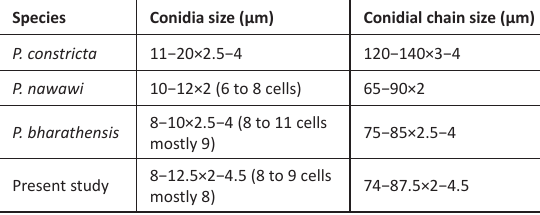
Table 1. Difference of conidia and conidial chain in genus Phalangispora